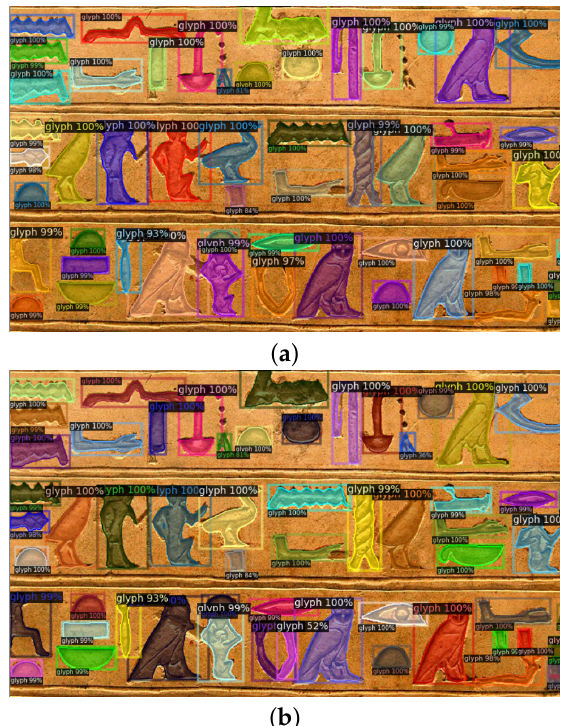
Figure 6. Segmentation results obtained with a training of 3000 epochs with an objectness score threshold equal to 0.7 ( a ) and with an objectness score threshold equal to 0.1 ( b